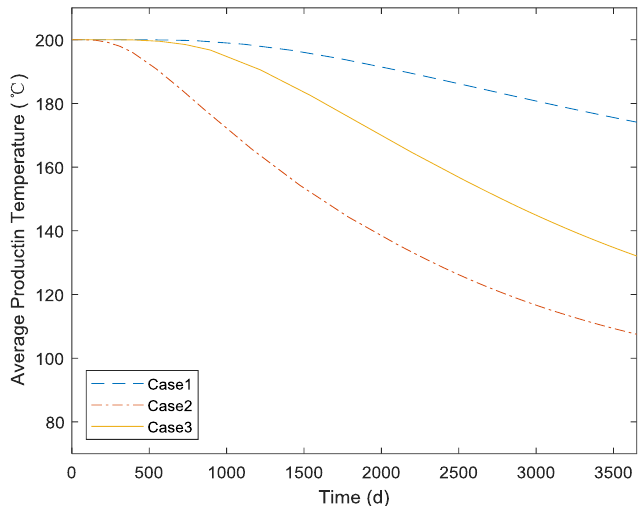
Figure 13. The average production temperature of the three cases.